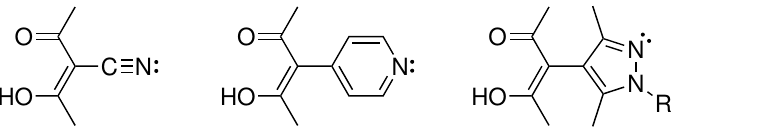
Figure 2. Chemical structures of heterobifunctional molecules utilized by our group for crystal engineering exhibiting nitrogen lone pairs.